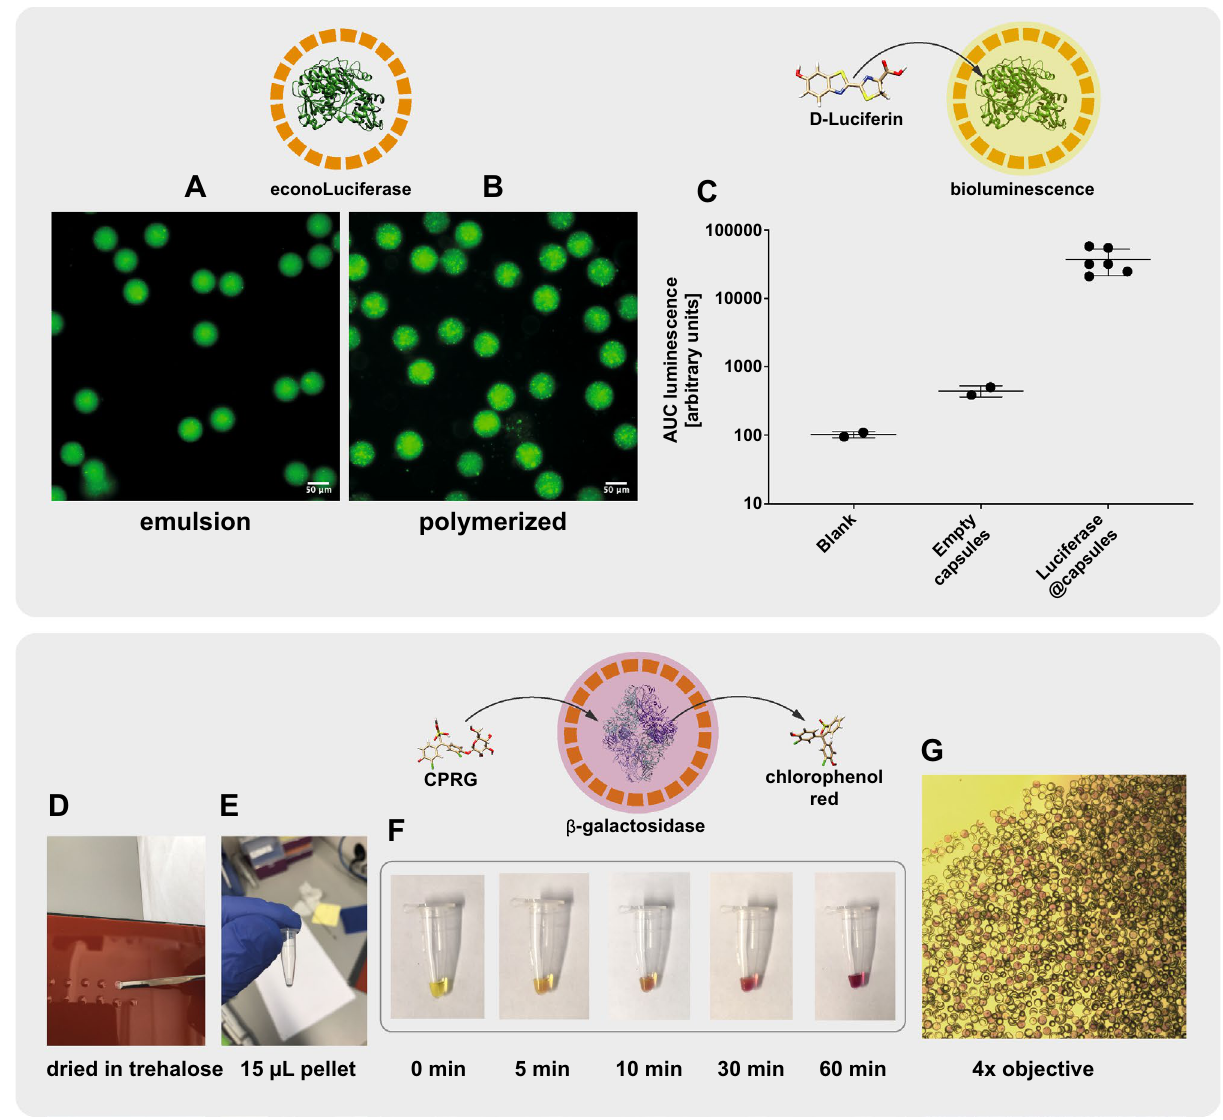
Figure 4. Direct encapsulation of functional enzymes in semi-permeable PEG-DA 258 microcapsules. A luciferase-GFP fusion protein was directly encapsulated in semi-permeable capsules. The fluorescent fusion protein allows for the visualization of the enzyme (A) in the double-emulsion, and (B) , in the polymerized capsules. (C) The encapsulated econoLuciferase shows a strong signal in a bioluminescent assay. Direct encapsulation of β -galactosidase. (D,E) Enzyme-containing capsules were dispersed in trehalose and air- ◦ dried at 37 C. (F) After rehydration with a solution containing CPRG, the substrate was hydrolyzed to chlorophenol red. (G) The solution was imaged with a color camera mounted on an inverted microscope with × 4 magnification. Capsules displayed a purple color in their interior, indicative of β -galactosidase enzymatic